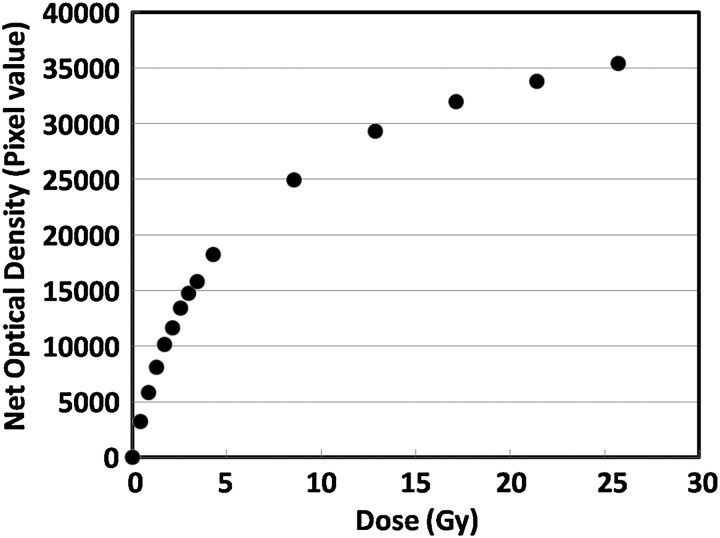
Plot of net optical density measured by a scanner green channel as a function of delivered dose. The films were oriented perpendicular to the beam axis and placed between two solid water phantoms each having a thickness of 10 cm. The source-to-film distance was 100 cm.